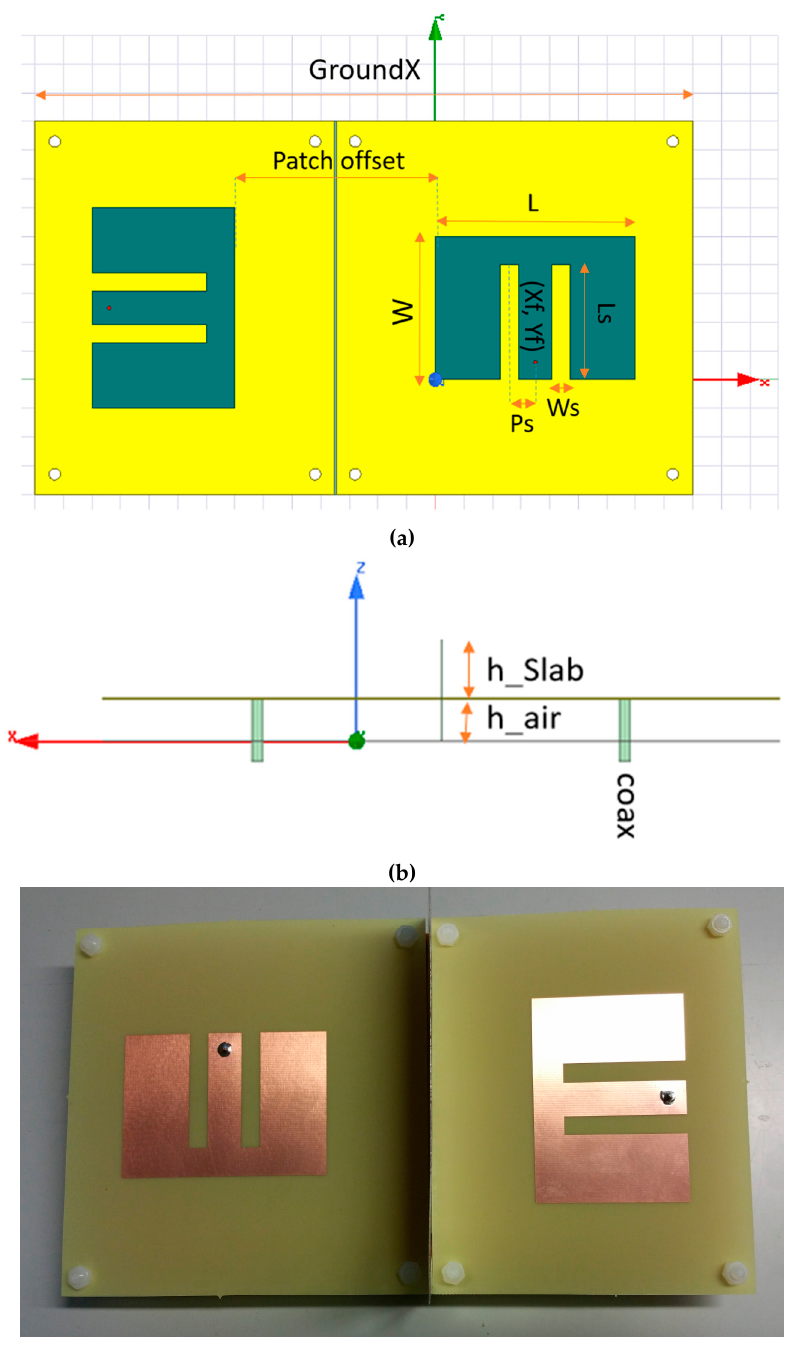
Figure 5. Geometry of a wide-band E-shaped antenna consisting of two parallel slots in the patch. ( a ) Top view, ( b ) side view, ( c ) antenna prototypes.